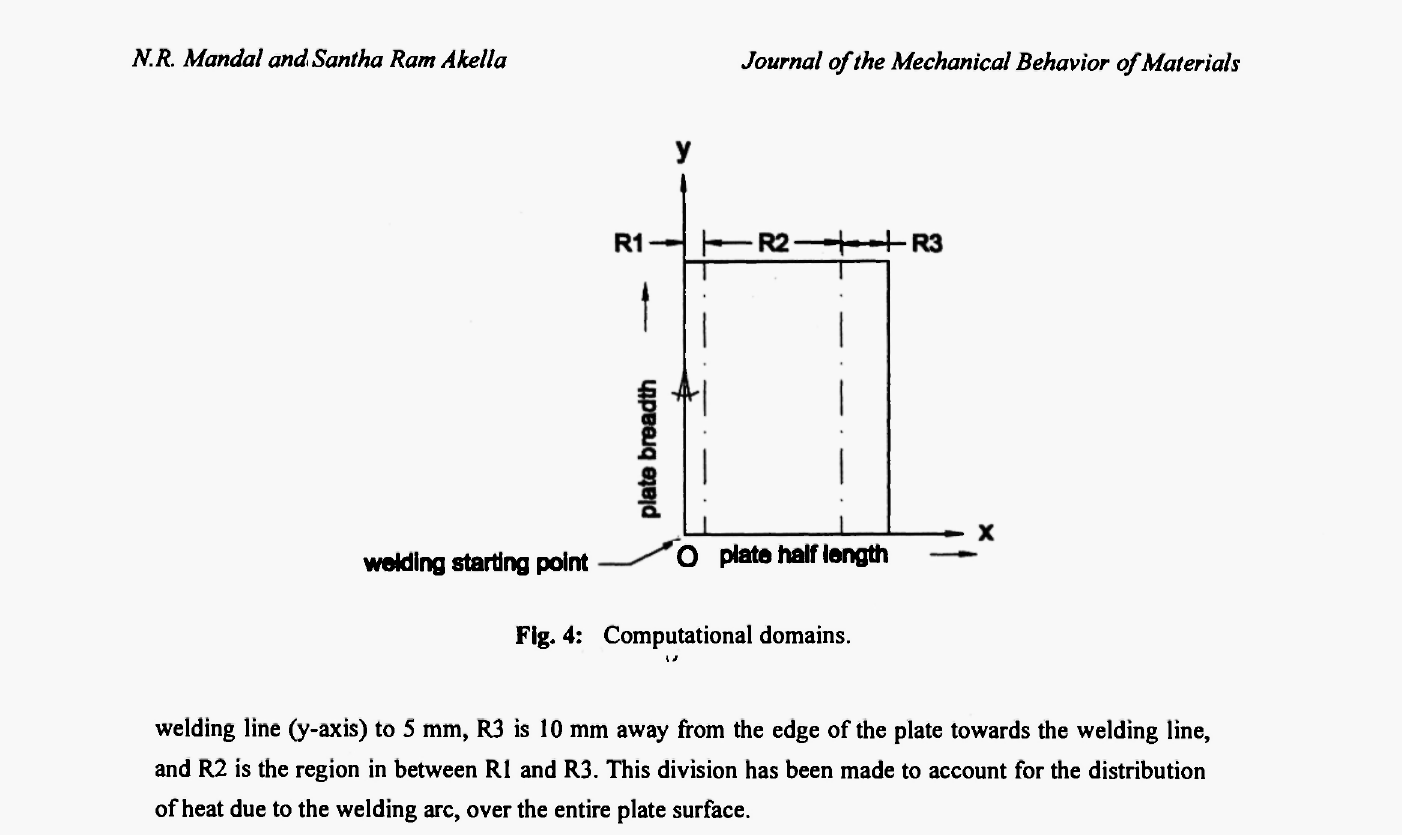
Fig. 4: Computational domains.